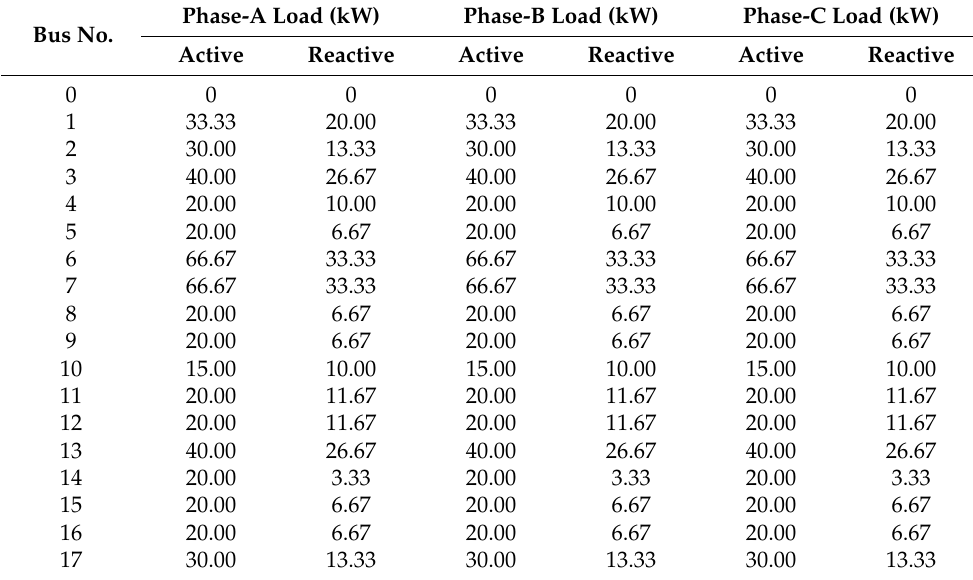
Table A1. 100% Electricity Power Subsystem